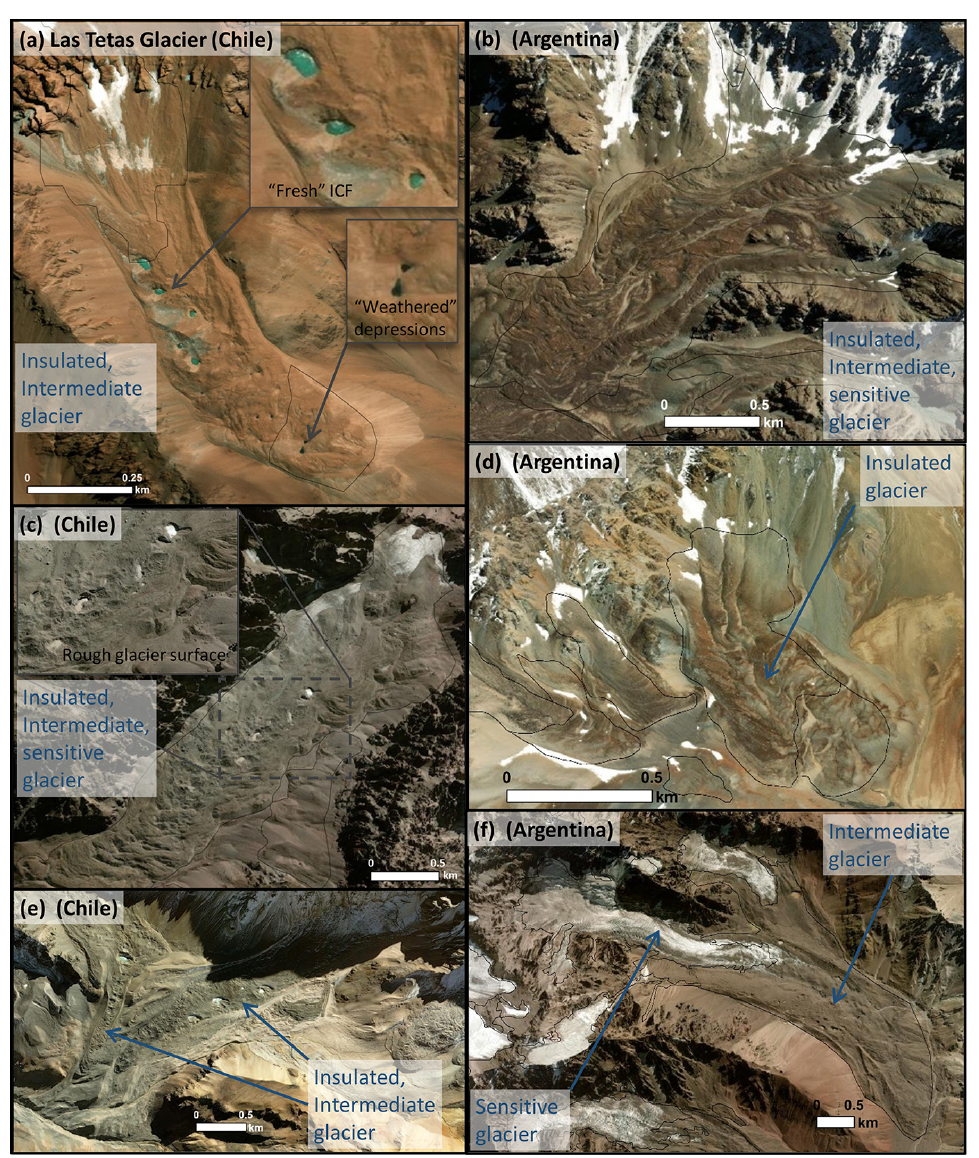
Figure 2. Examples from the semiarid Andes of Chile and Argentina are provided to clarify the proposed glacier types. All examples provided except for (d) contain multiple glacier types. (a) Las Tetas Glacier is made up of an intermediate glacier in its upper portion and an insulated glacier at lower elevations. (b) This glacier is dominated by the insulated glacier type, while (c) and (e) are dominated by the intermediate glacier type and have a “rough glacier surface”. (f) This glacier is a sensitive and intermediate glacier. (d) This glacier is a typical insulated glacier. Examples are provided of fresh ice collapse features (ICF) and weathered thermokarst depressions. The black outlines are glacier delineations from the national inventories. Image source (Esri basemap): (a) 11 March 2019 GeoEye (0.46m), (b) 9 April 2018 GeoEye (0.46m), (c) 1 April 2020 WorldView-2 (0.5m), (d) 9 January 2018 WorldView-2 (0.5m), (e) 6 May 2020 WorldView-2 (0.5m), (f) 1 April 2020 WorldView-2